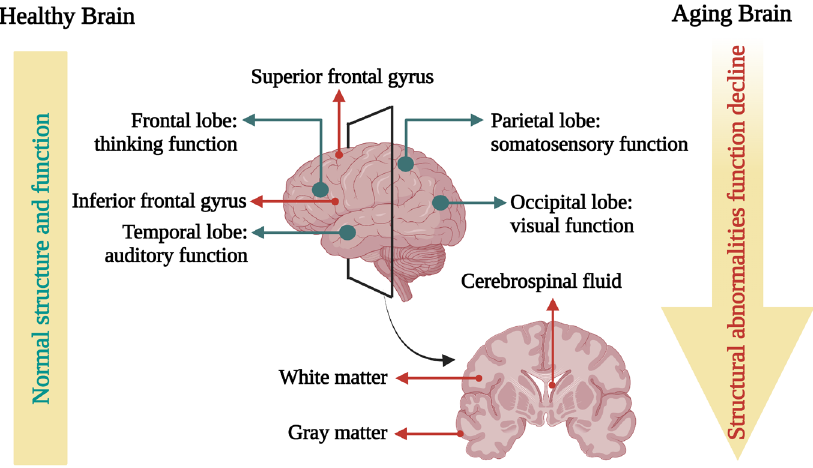
Figure 1. Hallmarks of brain aging.